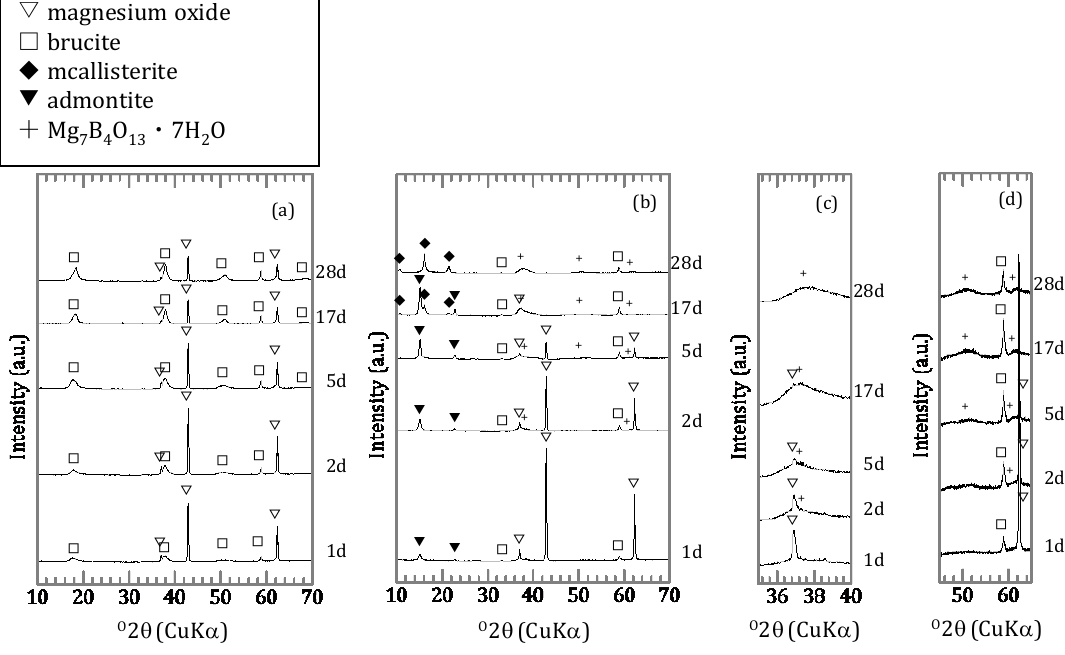
Figure 4. X-ray diffractometry (XRD) spectra of samples without amorphous silica; ( a ) [B] ini = 0.46 mmol/L and ( b ) [B] ini = 9.25 mmol/L with magnified ( b ) spectra for ( c ) 35–40° and ( d ) 45–65° in 2 θ .